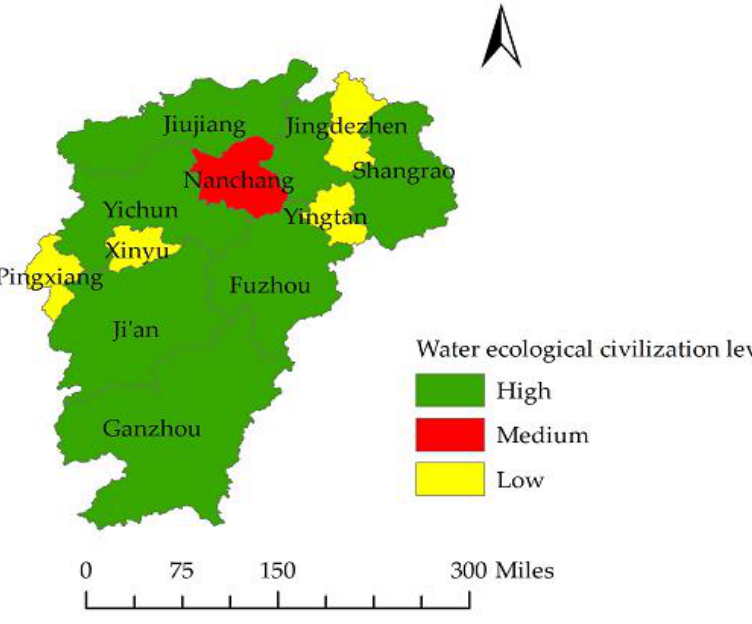
Figure 3. The spatial pattern of water ecological civilization in Jiangxi Province in 2020.